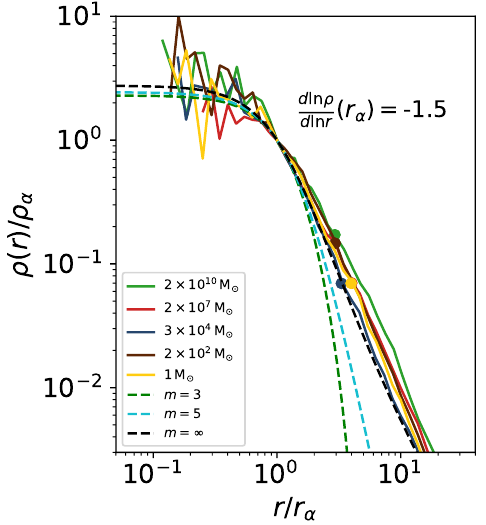
Figure 5. Mass density profiles of DM halos from numerical simulations showing the artificial cores appearing within the convergence radius (marked by color symbols). Within this radius, the timescale for two-body collisions between the (artificially massive) DM particles used in the simulation is shorter than the age of the Universe. The profiles have been taken from [23] and they represent DM halos with masses differing by as much as 10 orders of magnitude (see the inset). The dashed lines represent polytropes, with their index included in the inset. All profiles have been normalized to the density and radius where the logarithmic derivative of the profile (Equation (34)) equals − 1.5. Additional details can be found in